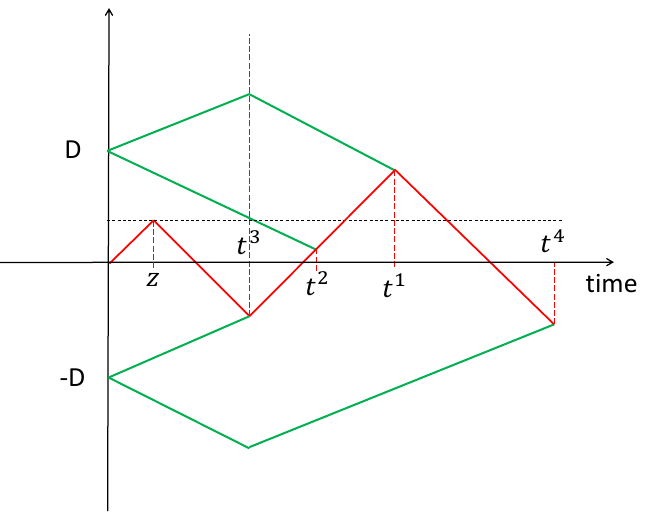
Figure 8. Optimal solutions with marker, i.e., (19) for v > 0.805; for lower speeds the optimal solutions are the ones without marker (Theorem 1). The fast player holds the